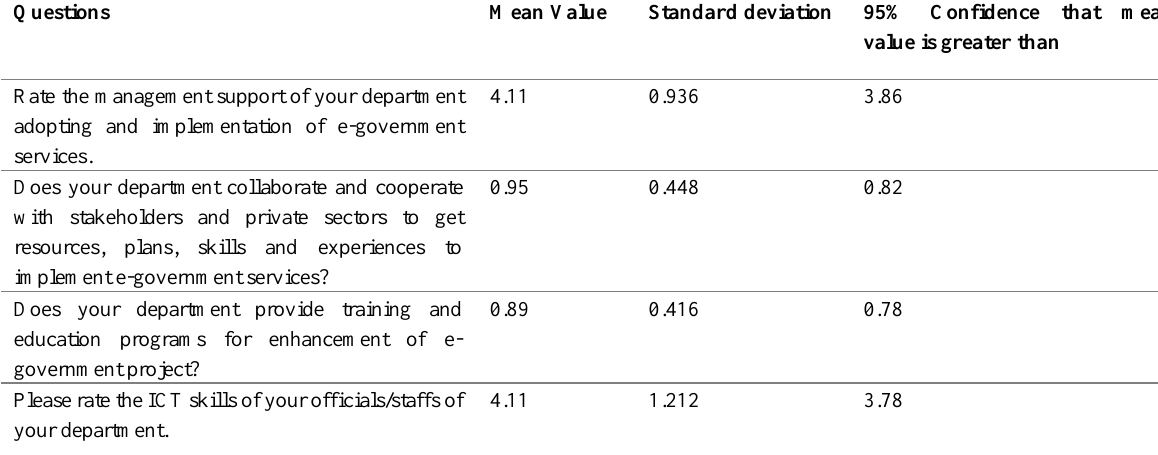
Table 16: Results of Questionnaire Processing That Are Related to Organizational